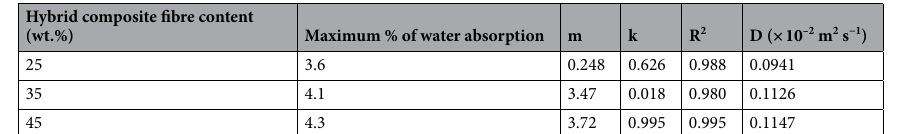
Hybrid composite fibre content (wt.%)